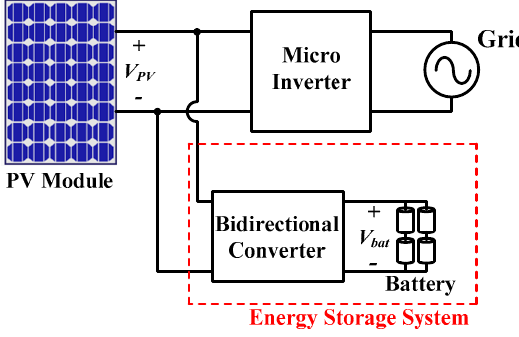
Figure 1. Photovoltaic (PV) generation using an energy storage system.